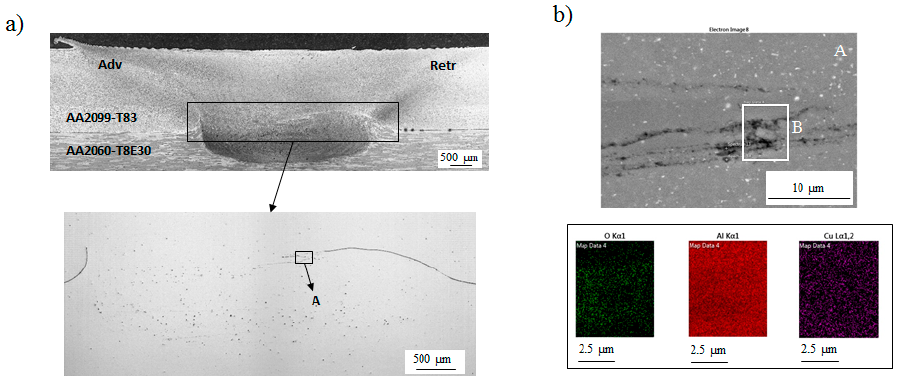
tional analysis of the remnants revealed contents of aluminium and copper, which are the